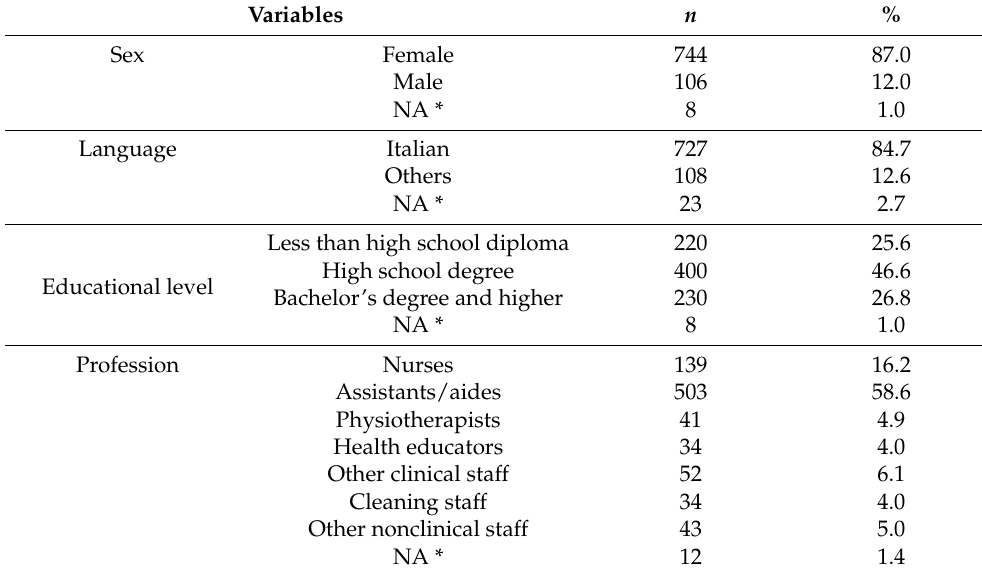
Table 1. Characteristics of the sample ( n =